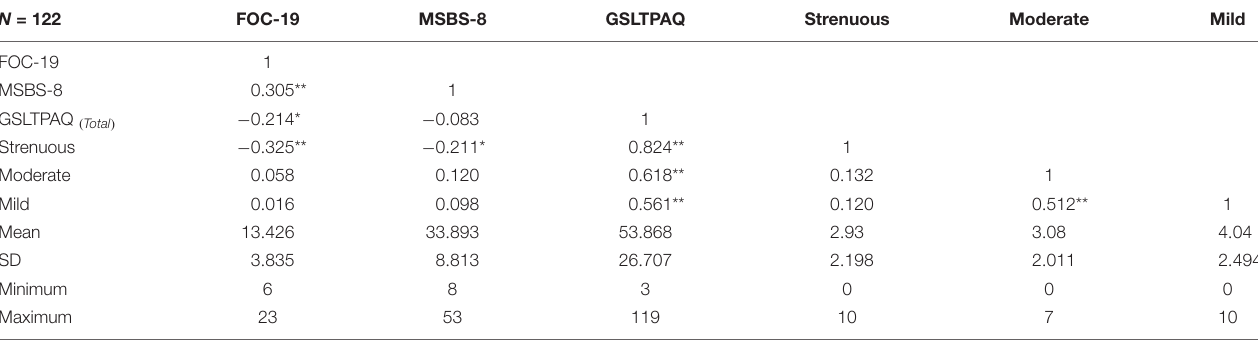
TABLE 1 | Descriptive statistics and correlation matrix.